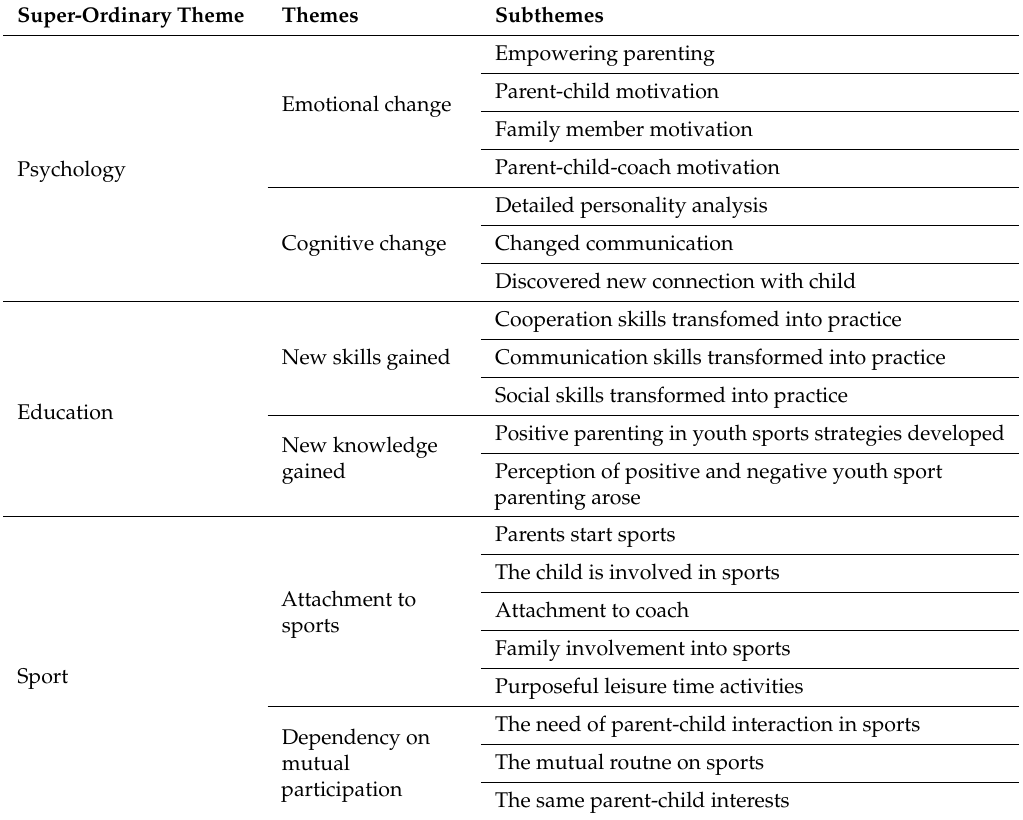
Table 3. After the